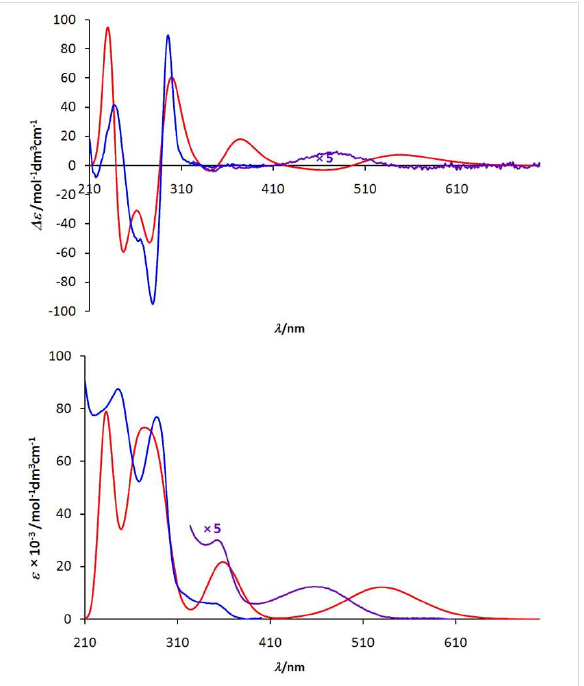
Figure 7: UV and CD spectra of the complex ( Λ )- 1· La. Blue and violet curve: experimentally determined spectra of ( Λ )- 1· La; red curve: calcu- lated spectrum of the Λ2 isomer of complex 1b· La calculated at the TD-DFT-PBE1PBE/LANL2DZ